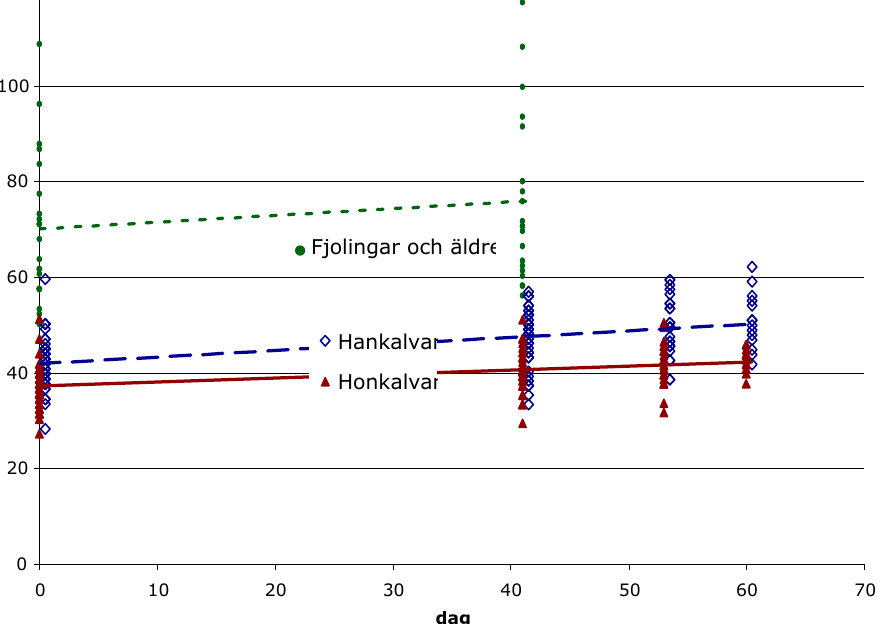
De genomsnittliga slakvikterna för kalvarna ökade under försöket (Tabell 1), liksom även rygglängd och längd på frambenet (radius). Slaktvikterna för tjurkalvar var 4,0 kg högre än för vajkalvar. Rygg och radius var 2,6 respektive 1,2 cm längre för tjurkalv än för vajkalv. Formklass förbättrades från slakt I (41 dagars utfodring) till slakt III (60 dagar). Musklernas pH förbättrades (sjönk) också signifikant under utfodringen, vilket är ett tecken på bättre näringsmässig status och högre glykogenreserver i muskulaturen. Vid slakt 0, före utfodring, hade 6 av de 10 slaktade kalvarna pH- värden över 6,2 (gräns för kvalitetsfelet DFD) i bog, medan pH i ytterfilé och ytterlår låg på acceptabla nivåer och endast i tre fall över 5,8, vilket generellt används som övre gräns för ett normalt pH (Wiklund 1996). Vid slakt I, efter 41 dagars utfodring, hade pH-värdena i samtliga undersökta muskler sjunkit signifikant. Till slakt III, efter 60 dagar, hade de sjunkit ytterligare och högsta pH- värdet i bog låg då på 6,0. Kalvens kön påverkade inte pH och klassning. Storlek (rygglängd och längd på radius) var positivt korrelerad till slaktvikt, även inom slakttillfälle. Också pH påverkades positivt (lägre värden) av högre slaktvikt, däremot påverkades inte klassningen